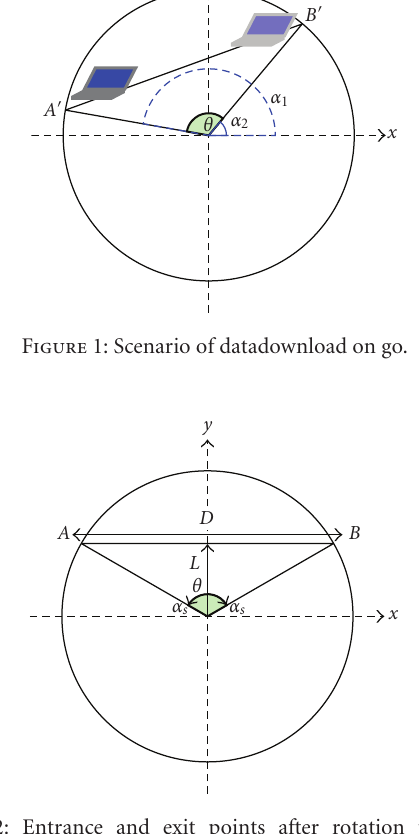
180 ◦ instead of 0 ◦ 360 ◦ for calculation of average throughput over simplified horizontal path. The calculation of average throughput over simplified horizontal path is given